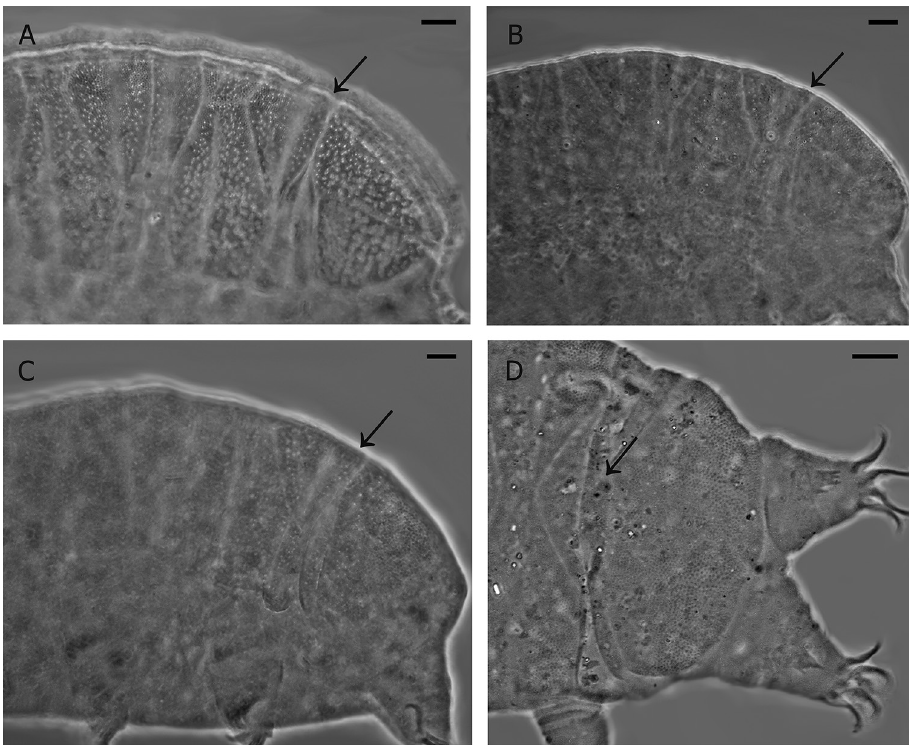
Figure 3. Divided third median plate (arrows indicate its caudal piece) in A Bryodelphax brevidentatus Kaczmarek, Michalczyk & Degma, 2005 B B. meronensis Pilato, Lisi & Binda, 2010 C B. parvulus Thu- lin, 1928, and D B. weglarskae (Pilato, 1972). Scale bars 10